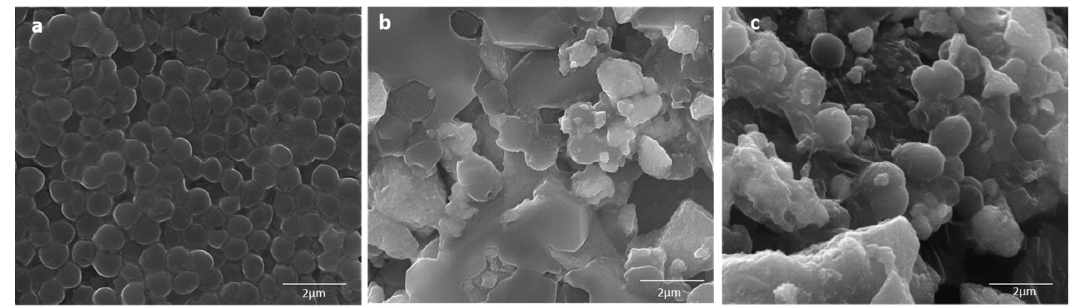
Figure 8. SEM micrographs of S. aureus : ( a ) control (untreated cells); ( b ) Ag NPs at 100 µ g / mL; ( c ) TiO 2 NPs at 100 µ g / Figure. 8. SEM micrographs of S. aureus: ( a ) control (untreated cells); ( b ) Ag NPs at 100 µg/mL; ( c ) TiO 2 NPs at 100 µg/mL.